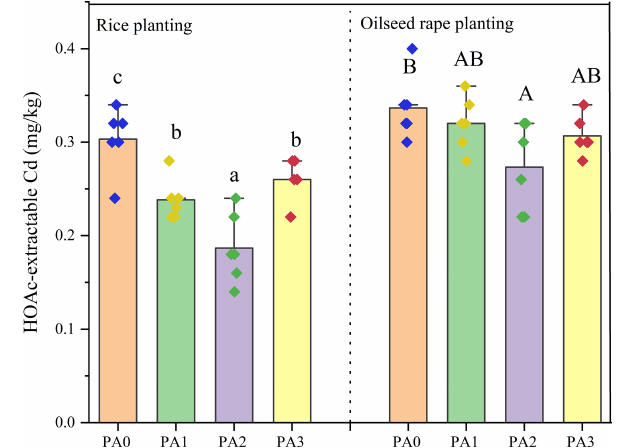
Figure 2. The effects of amendments on Cd bioavailability in soil. Dots represent the value of each sample. Bars followed with differ- ent lowercase letters (a–c) and capital letters (A and B) indicate the significant ( p ≤ 0 . 05) difference among different treatments in rice planting and oilseed rape planting according to the LSD test. Values represent means ± standard